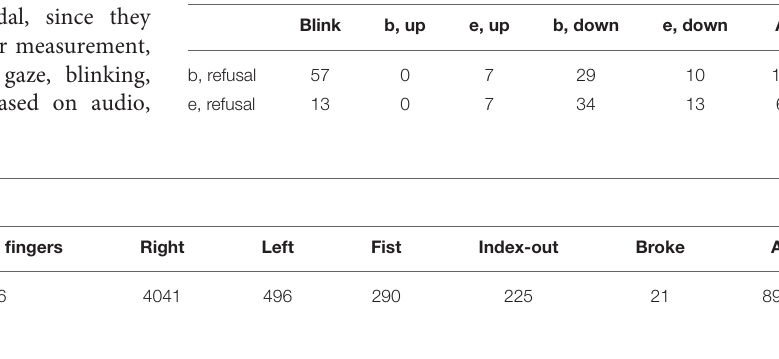
TABLE 8 | Emblem/refusal—frequency of items from the gaze class.